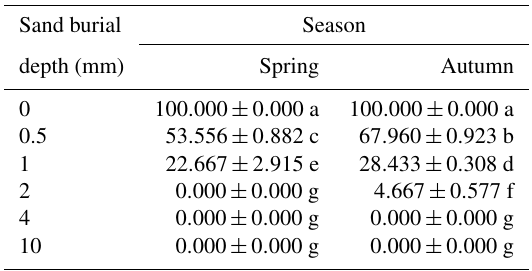
Table 1. Changes in the percentage cover of Bryum argenteum Hedw. within a biocrust in response to sand burial depth in spring and autumn. Sand